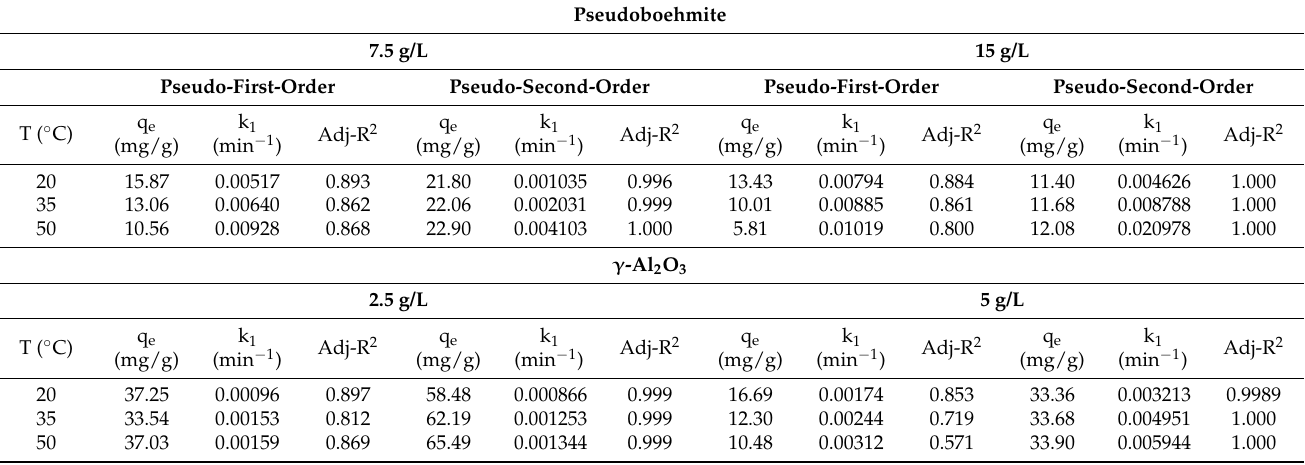
Figure 7. Lagergren’s pseudo-second-order rate fit for ( a ) pseudoboehmite ( b ) γ -Al 2 O 3 (experimental conditions: initial pH 8.5, dosages and temperatures in the legend). Table 3. Lagergren’s pseudo-first- and -second-order kinetics fit results.